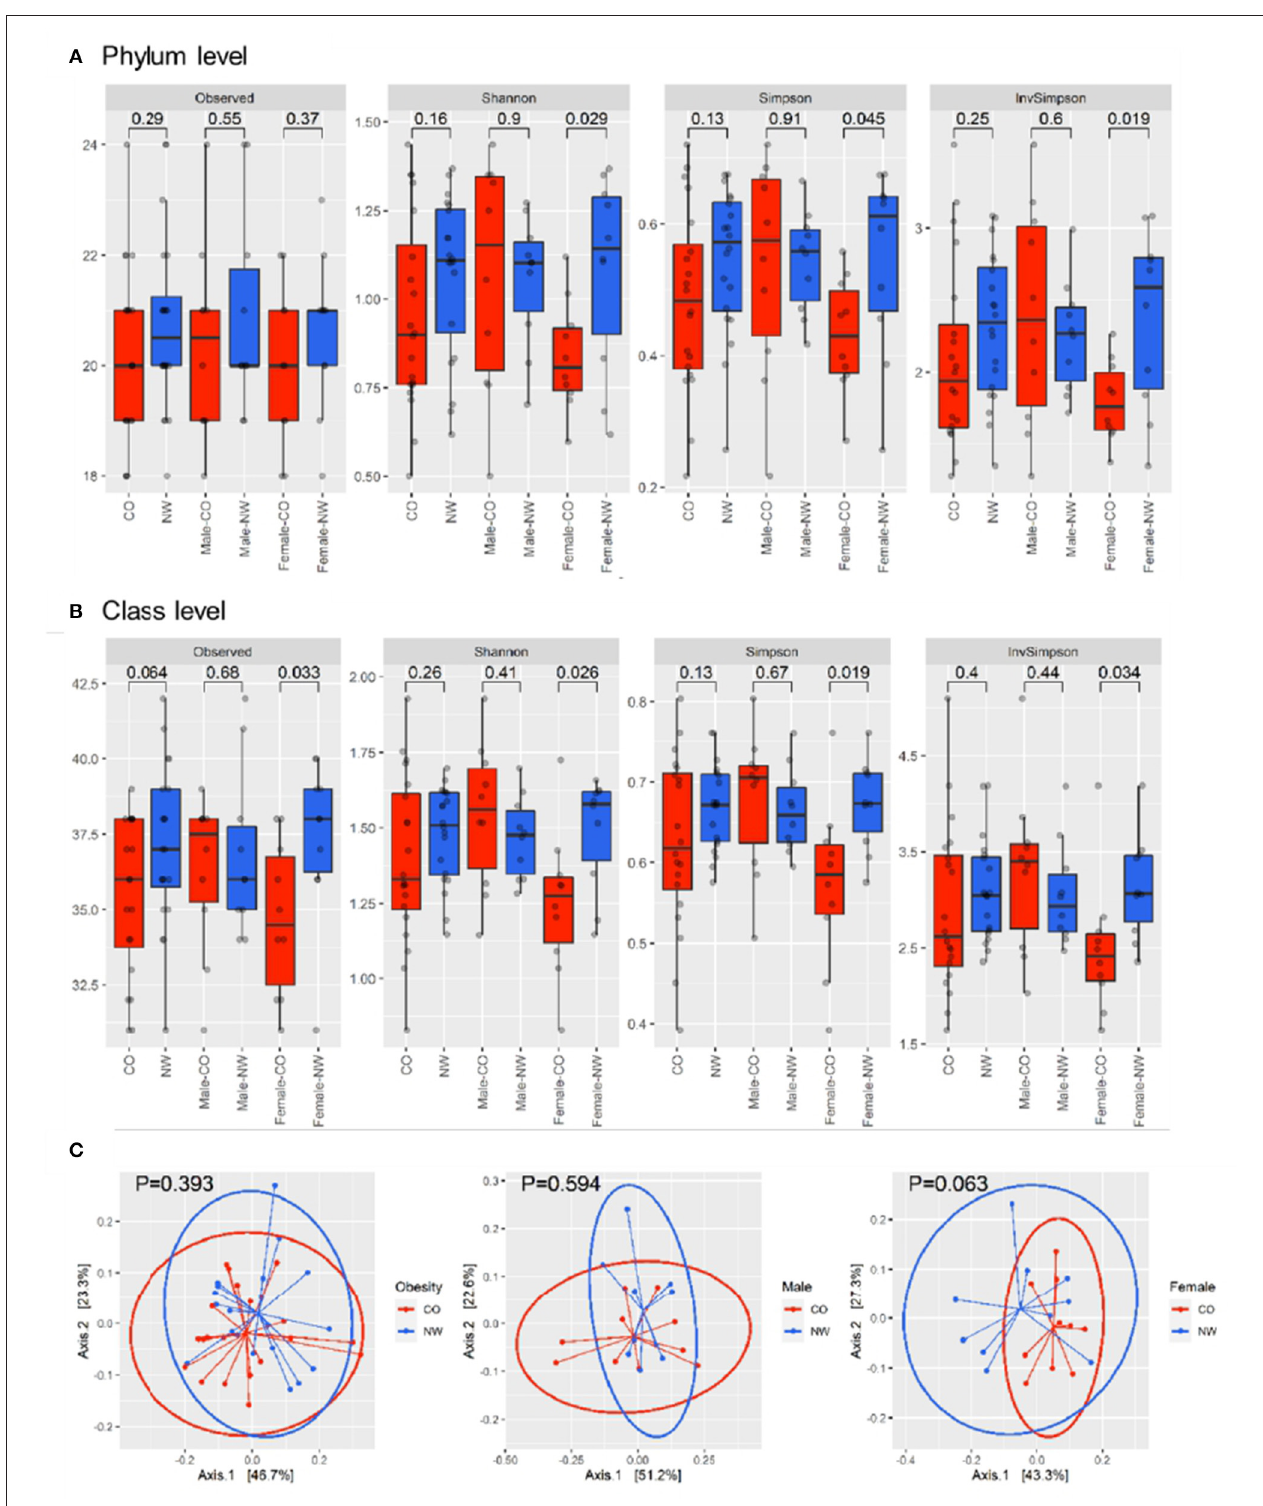
FIGURE 1 | Alpha and beta diversity were compared between subjects with central obesity (CO) and normal weight (NW). Bacterial community richness was defined by the observed number of operational taxonomic units (OTUs) and alpha diversity was calculated using the Shannon index, Simpson index, and inverse Simpson index for both phylum (A) and class levels (B) . The analysis of beta diversity was calculated using PCoA of Bray-Curtis distances (C) .